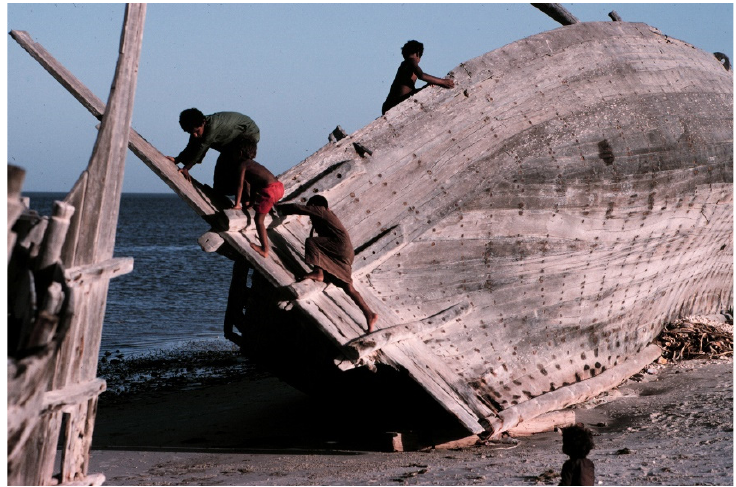
Figure 3. Children play on abandoned cargo badans on. Muhut island. Photo courtesy of Roger Garwood.